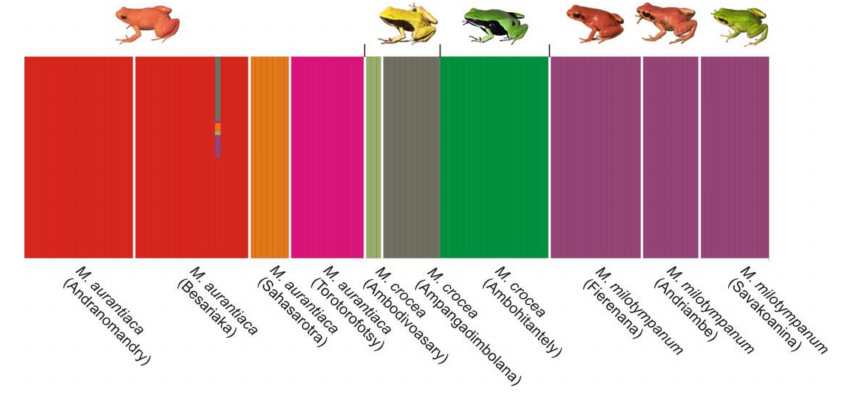
Figure 6. Bayesian analysis of the selected populations of the M. madagascariensis group used for the analysis of population structure. Barplot of the clustering solution with the highest posterior probability (K = 7). Each individual in the analysis is represented by a vertical bar, and groups of individuals of the same sampling site are grouped in boxes with an associated label below. The only significantly admixed individual (from the Besariaka population of M. aurantiaca ) presents its genotype partitioned in colors according to the proportion of it that resembles each of the clusters (e.g., 32% brown reflecting that 32% of the genotype matches that of the M. crocea cluster of